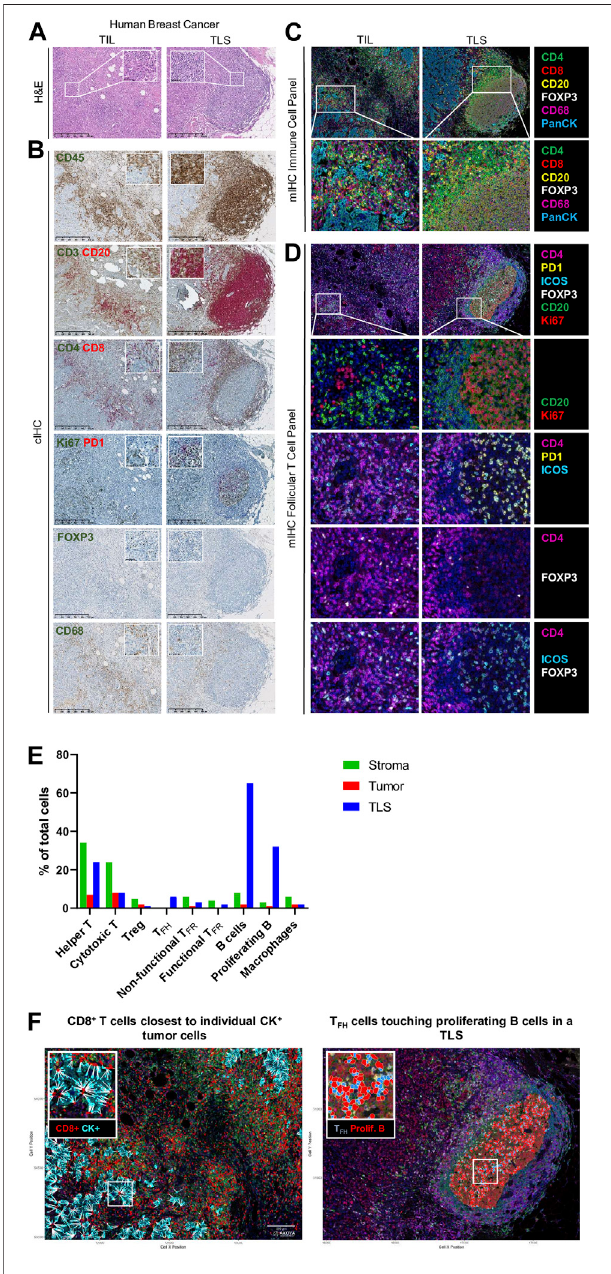
FIGURE2| Immunepro fi lingofbreastcancer. (A – D) Representativeimages of tumor-in fi ltrating lymphocyte (TIL) and tertiary lymphoid structure (TLS) in FFPE breast cancer sections detected by (A) hematoxylin and eosin staining (H&E), (B) chromogenicIHC(cIHC),and (C,D) multiplexIHC(mIHC). (E) Quanti fi cationof immunecellsinstromal,tumoral,andTLSareasusingInFormandPhenoptrReports. (F) SpatialdistributionofimmunecellsincludingCD8 + Tcellsclosesttoindividual CK + tumor cells and T FH cells touching proliferating B cells in a TLS. H&E and cIHCslideswerescanned at × 40magni fi cationand theimagesaredisplayed at × 5 and × 40 magni fi cation. mIHC slides were scanned at × 20 magni fi cation.